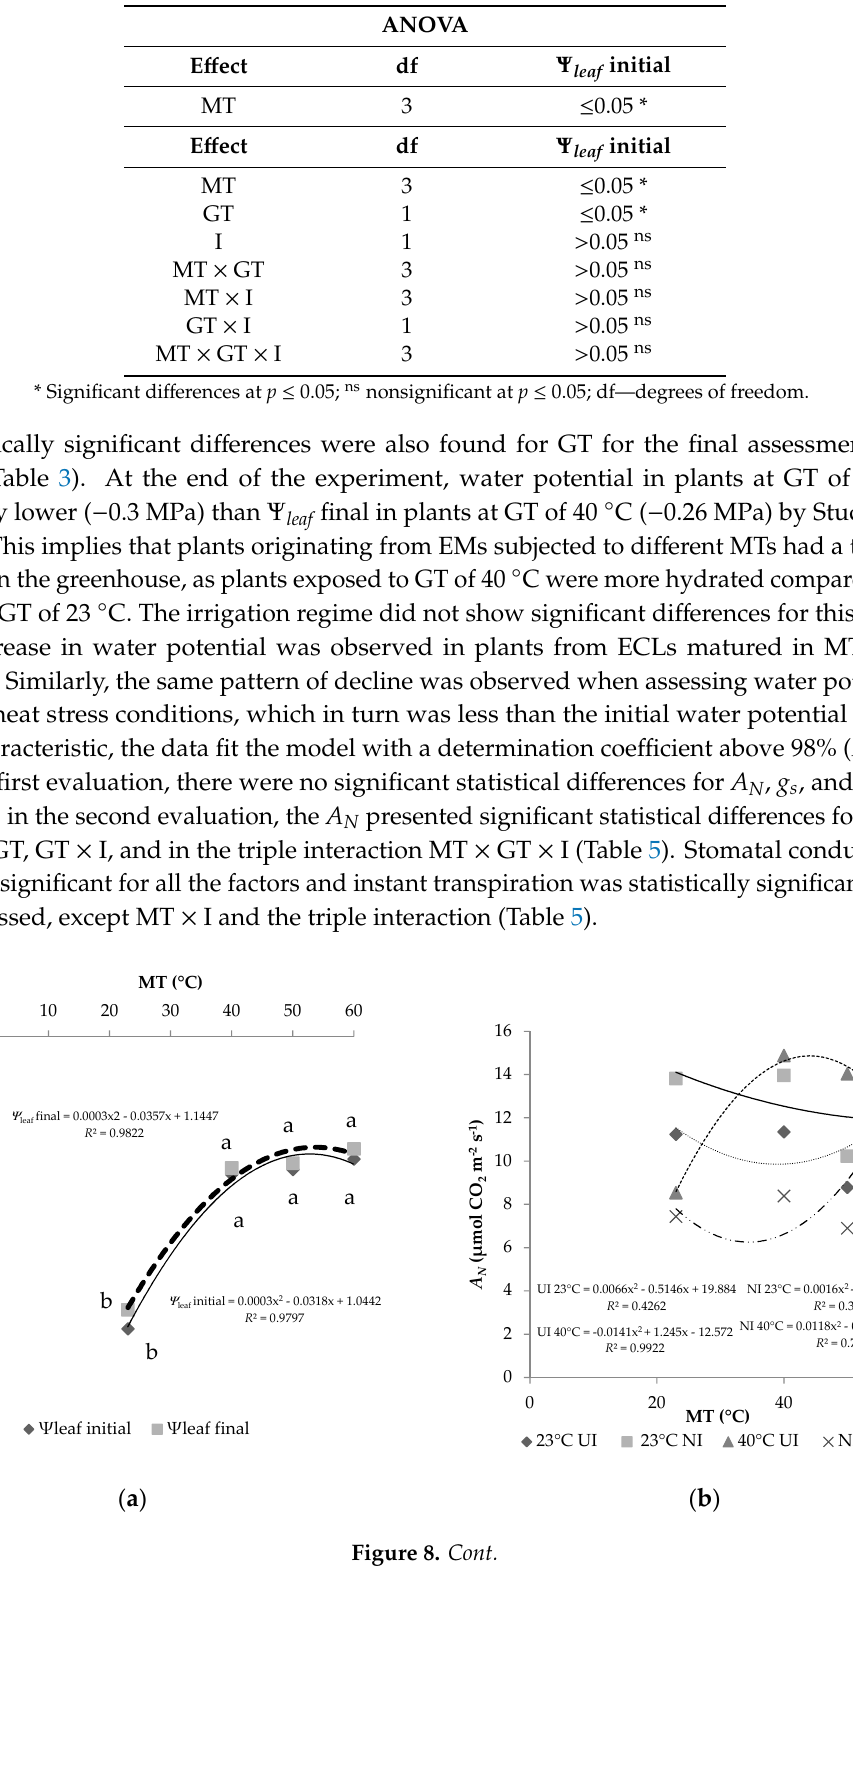
Table 3. Analysis of variance (ANOVA) for the e ff ect of di ff erent maturation temperatures (MT) and greenhouse temperatures (GT) on the initial and final water potential ( Ψ leaf initial and Ψ leaf final, respectively) in plants of Pinus radiata D.Don under irrigation and / or no irrigation conditions (I).